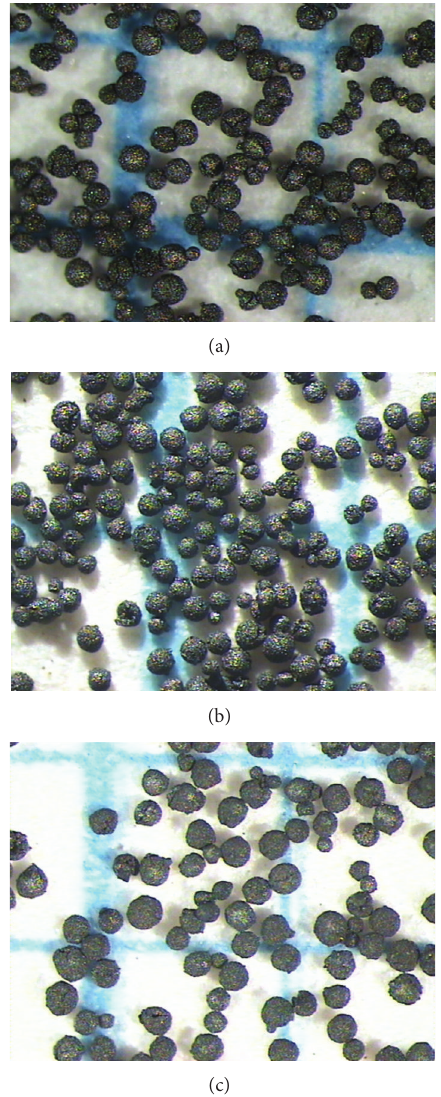
Figure 14: Light microscope pictures of 5.6% MgO 1300 particles both fresh and used after 50 cycles. (a) fresh particles; (b) particles on which 50 cycles of 2s reduction was performed; (c) particles on which 50 cycles of 14s reduction was